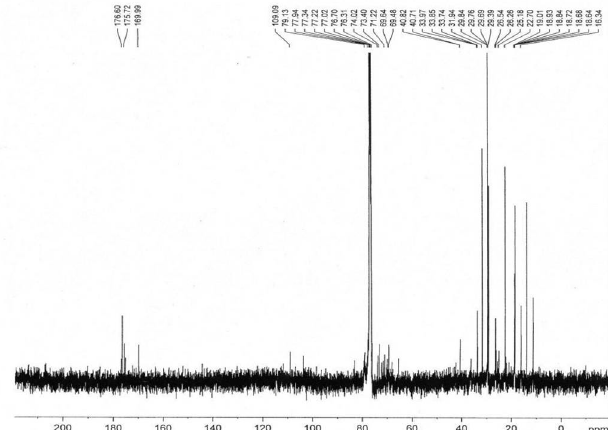
Fig 2 . 13 C nuclear magnetic resonance of the major sugar ester compound isolated from S. bistellatum.